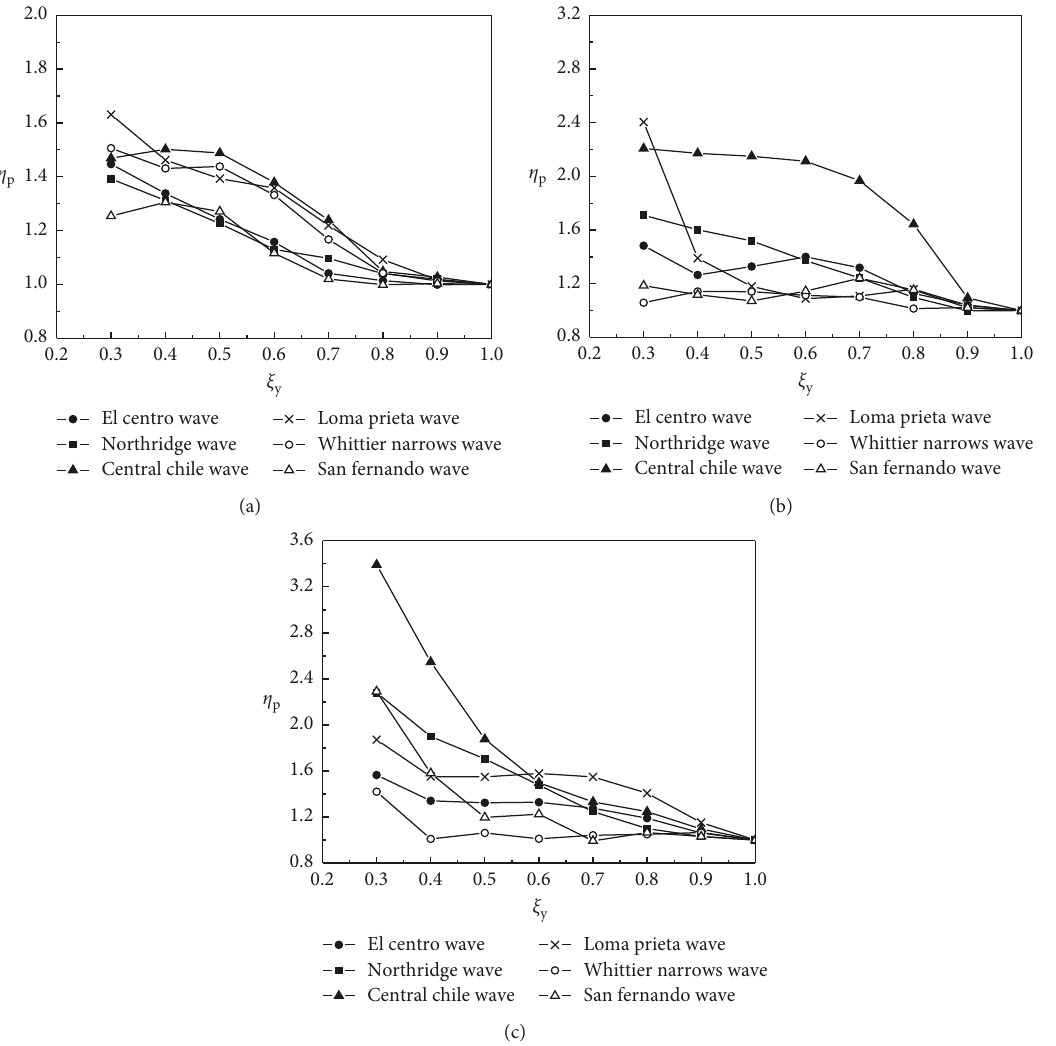
Figure 12: Influence of yielding coefficient of storey shear force ξ and (c) 6-storey structure ( T � 0.45s).